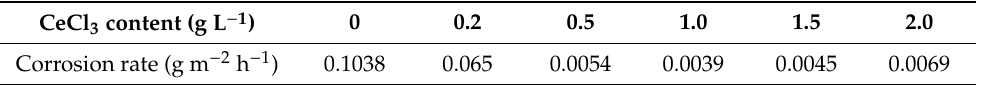
Table 5. Corrosion rate of the Pd-Ni Film in a 20 wt % H 2 SO 4 solution at 80 °C from weight loss tests. CeCl 3 content (g L − 1 )